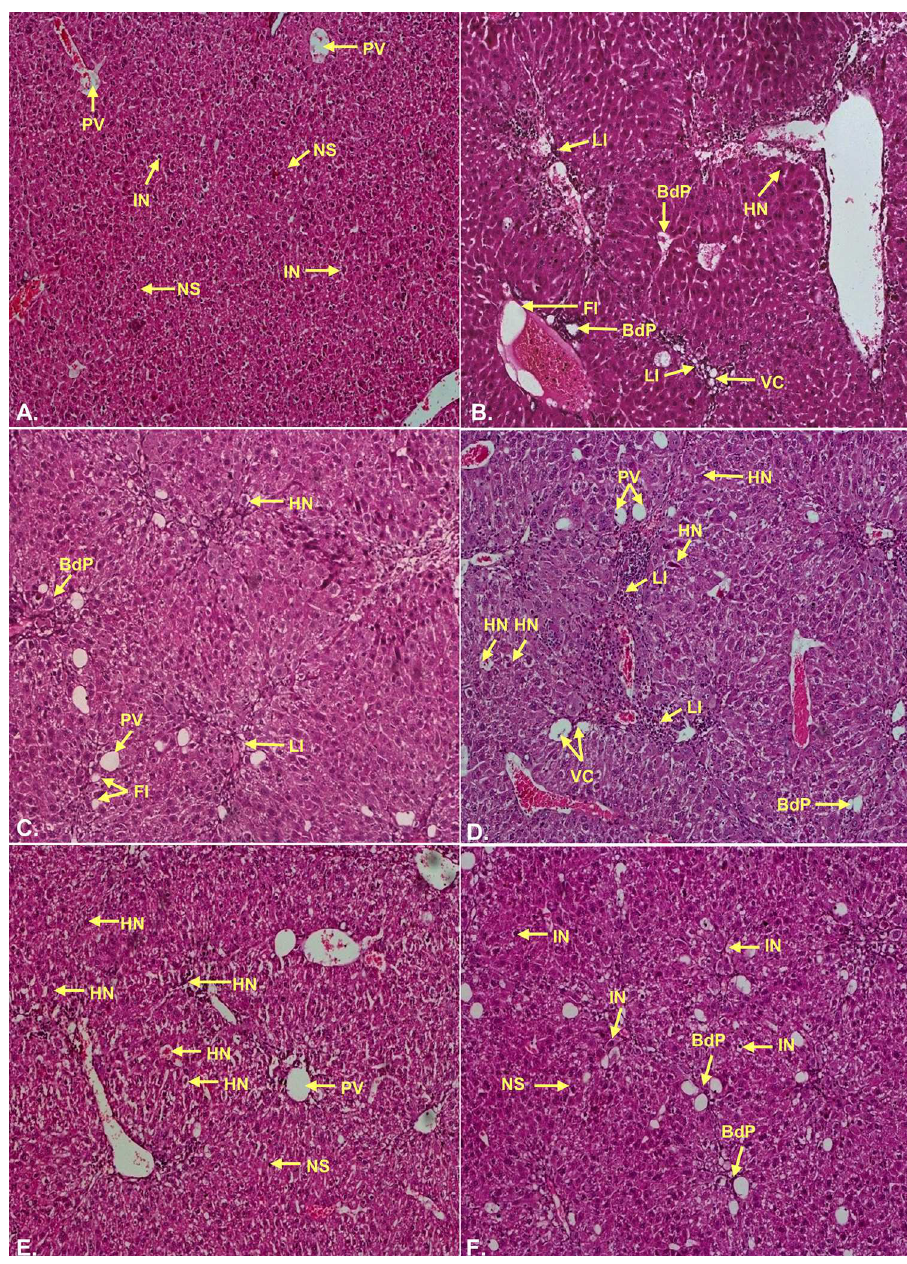
Fig 10. Photomicrographs (100×) of the histopathological examinations of the liver samples of different groups. Even though the extract treated groups possessed injury marks however, the extent of signs of injury were much lower in the extract treated groups compared to CCl 4 group.(A) Control group liver demonstrated normal liver architecture with normal sinusoids (NS), hepatocytes with intact nucleus (IN), un-inflamed portal vein (PV); (B) CCl 4 group liver demonstrated significant loss of hepatocellular architecture with extensive fatty infiltration (FI) leading to steatosis, bile duct proliferation (BdP), vascular congestion (VC) and haemorrhagic necrosis (HN) around portal vein. Loss of hepatic nodular structure and disorganized hepatocytes marked the CCl 4 induced liver damage; (C) Silymarin group demonstrated hepatoprotective activity by substantial amendment of proliferated bile duct (Bd) with normal sinusoids (NS) and intact portal veins (PV); (D) CBLL group was marked by less leukocyte infiltrations (LI), sinusoidal dilations (SD) and bile duct proliferation (BdP); (E) CBLM group reflected comparatively less haemorrhagic necrosis (HN) and fatty infiltrations (FI); (F) CBLH group demonstrated lowering of most of the injury signs however, leukocyte infiltrations (LI) could be identified in the liver samples.